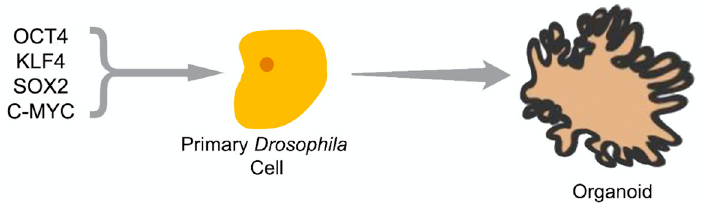
Figure 4. Experimental procedure: Transformation of primary Drosophila cells with the four stem ‐ cell genes from humans: OCT4 , KLF4 , SOX2 , and C ‐ MYC . The cells are expected to develop induced pluripotent stem (iPS) cell ‐ like characteristics in media containing 2 kinase inhibitors (2i media) and grow into an organoid once differentiation factors are applied or 2i media is removed.